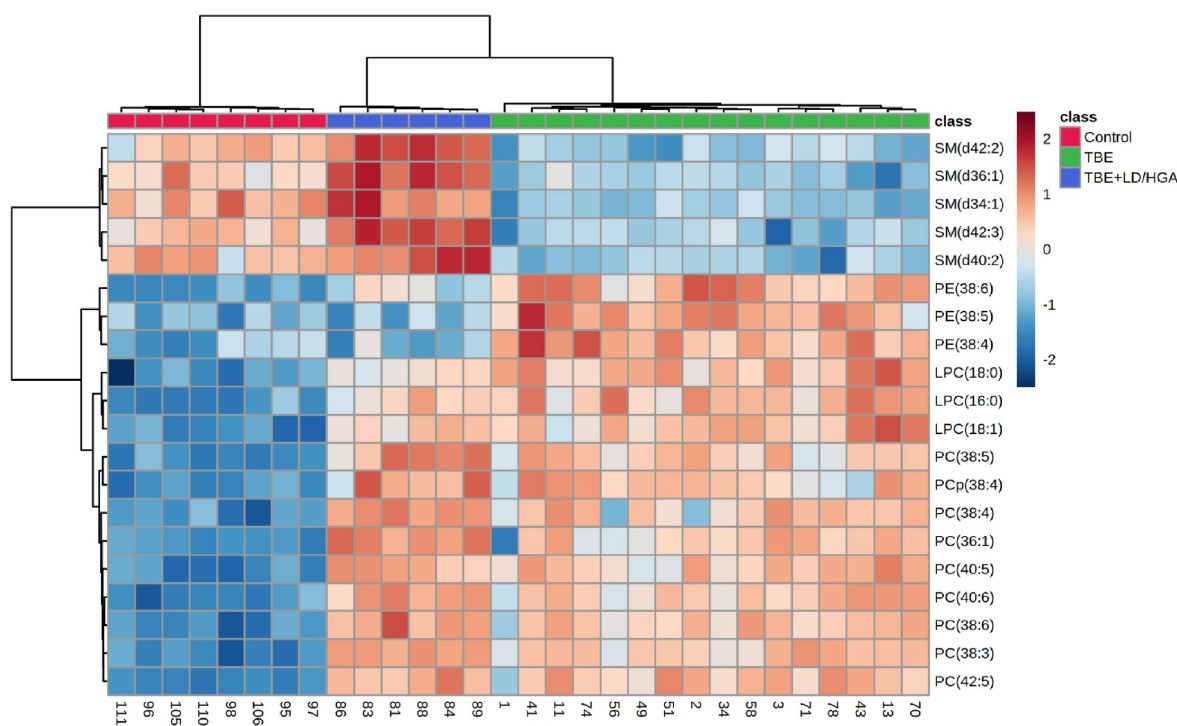
Figure 2. Two-dimensional hierarchical clustering heat map of the 20 most discriminating PL species (according to One-way ANOVA) identified in the plasma of healthy subjects (Control) and TBE patients (TBE) and TBE patients with co-infections (TBE +